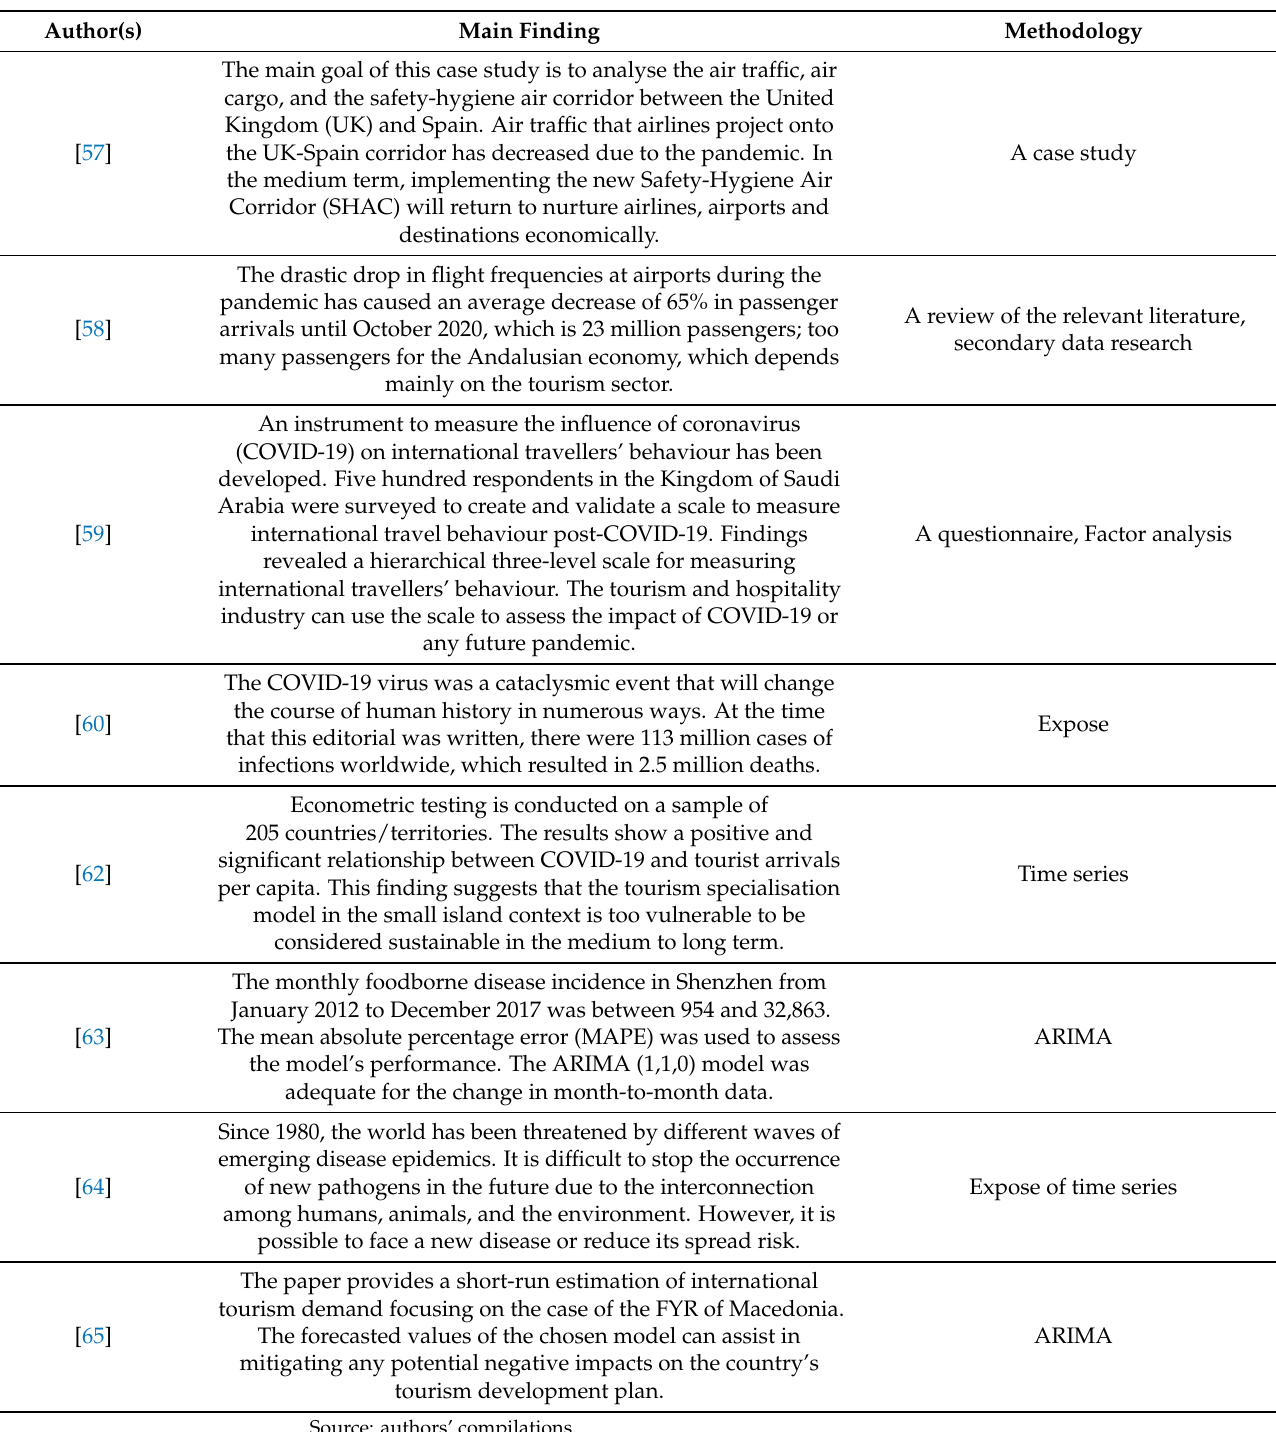
Table A1. The review of some most recent post-effect research of a